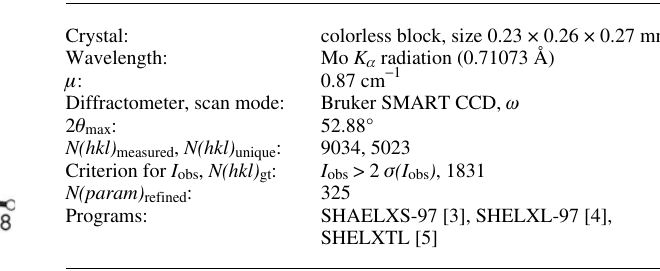
Table 1. Data collection and handling.